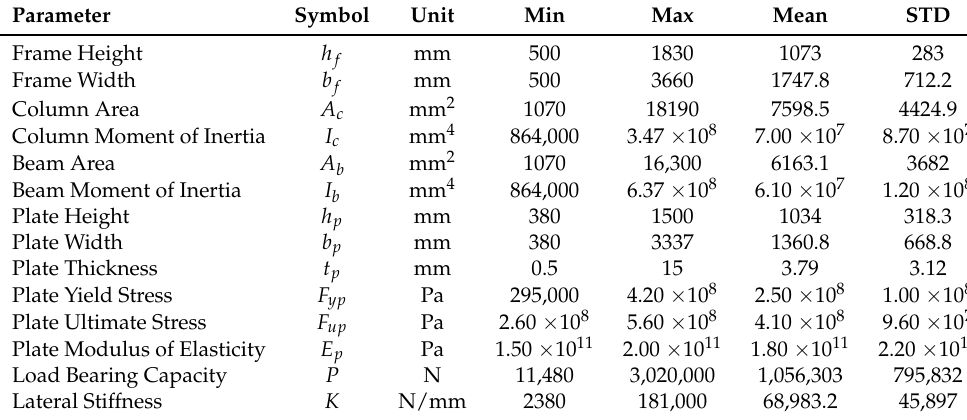
Table 1. Statistics of the parameters in SPSW model.